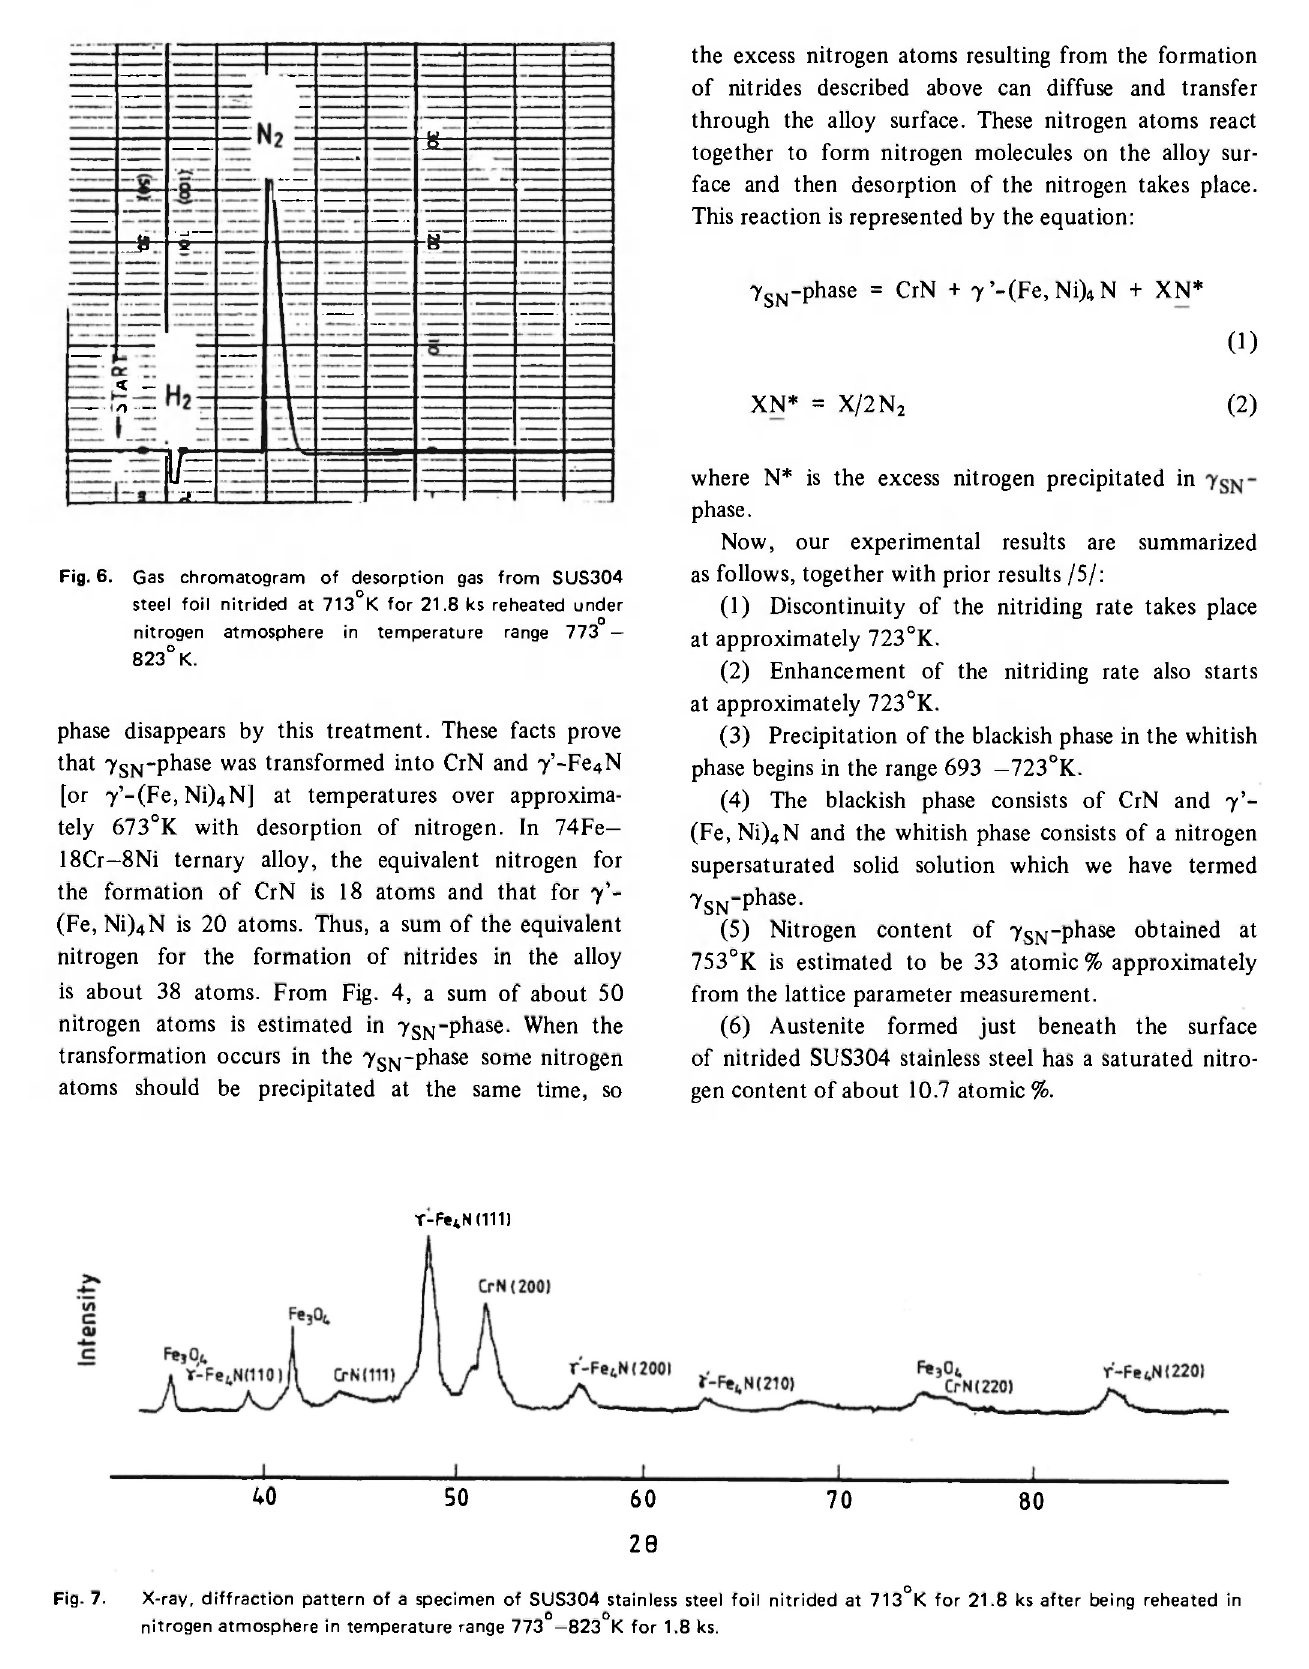
Fig. 7. X-ray, diffraction pattern of a specimen of SUS304 stainless steel foil nitrided at 713°K for 21.8 ks after being reheated in ο 0 nitrogen atmosphere in temperature range 773 -823 Κ for 1.8